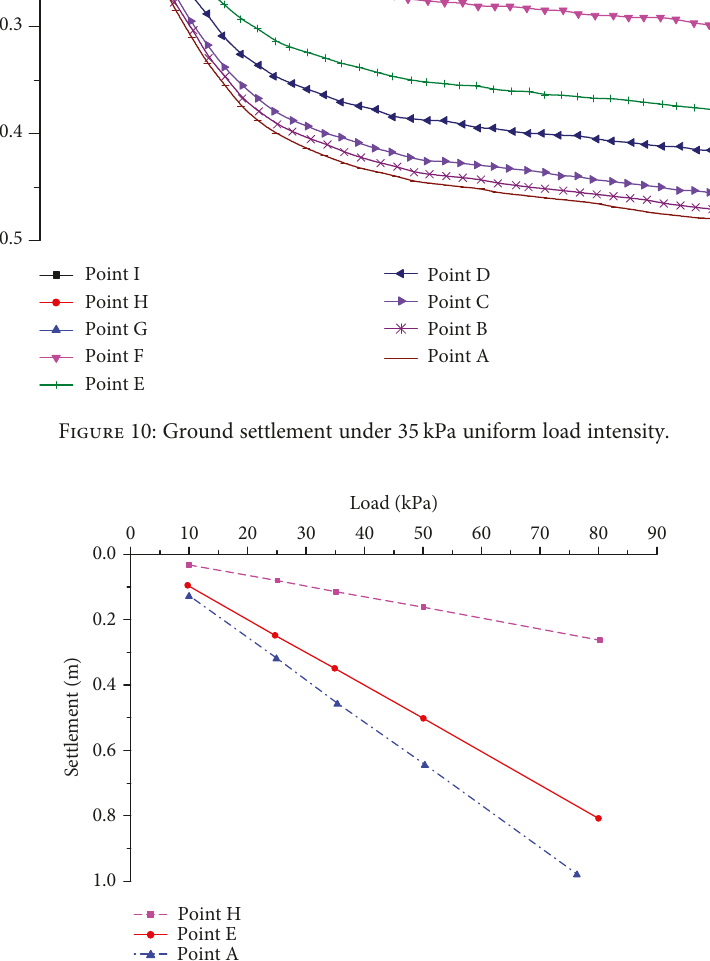
Figure 11: Variation of ground settlement with loading intensity. Table 6: Load intensity varies with time (unit: Comparison of settlement caused by self-weight, upper loading, and groundwater withdrawal is shown in Figure 15. Settlement caused by groundwater withdrawal and upper loading dominant from 0 to 200 years almost accounting for 97% of the total settlement. The settlement caused by self-weight gradually increases and reaches to 6.5% of the total settlement. However, settlement caused by drainage is higher than self-weight all the time.